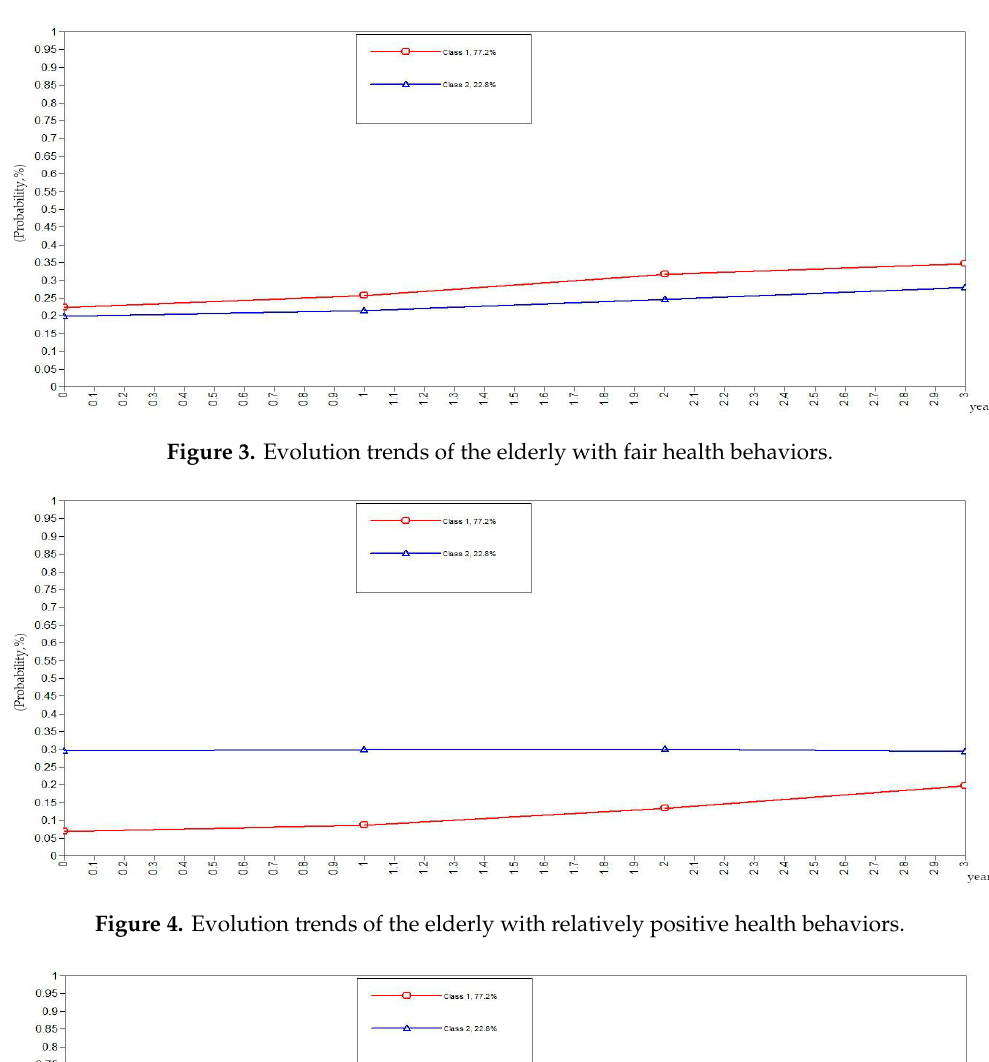
Figure 2. Evolution trends of the elderly with relatively negative health behaviors.